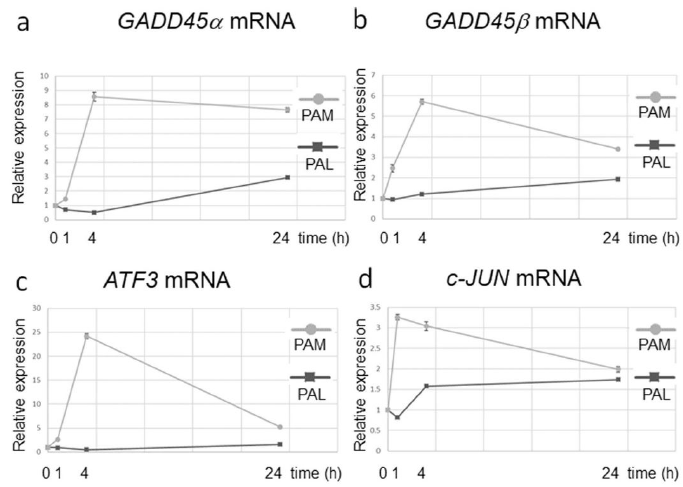
Figure 5. Differences in gene expression dynamics between PTS- (medium, plasma-activated medium (“PAM”)) and PTS-exposed (Ringer’s lactate, plasma-activated Ringer’s lactate (“PAL”)) U251SP cells. Relative mRNA expression of GADD45 α ( a ), GADD45 β ( b ), ATF3 ( c ), and c-JUN ( d ) was calculated using qRT-PCR. Reproduced from [63] .